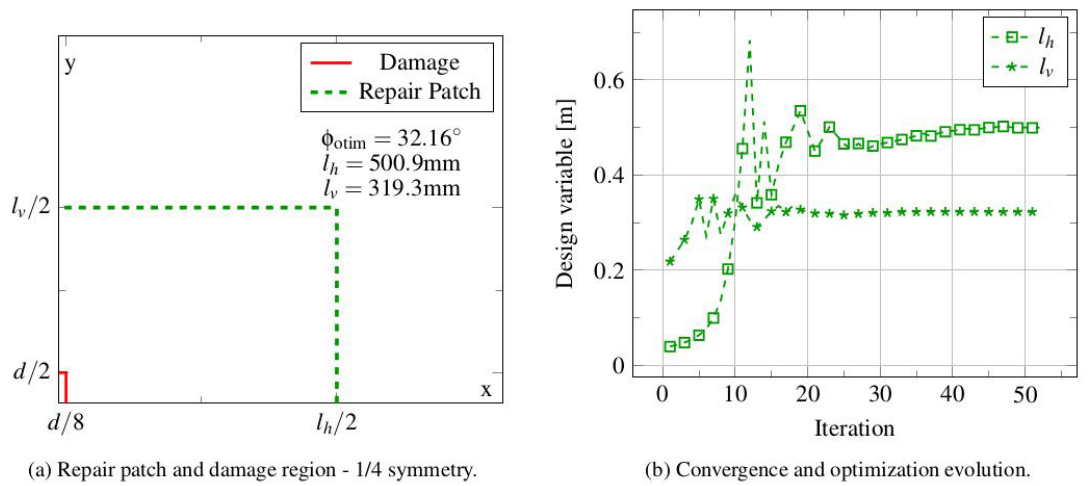
Figure 6. Rectangular repair patch - FC with an unsymmetrical stacking